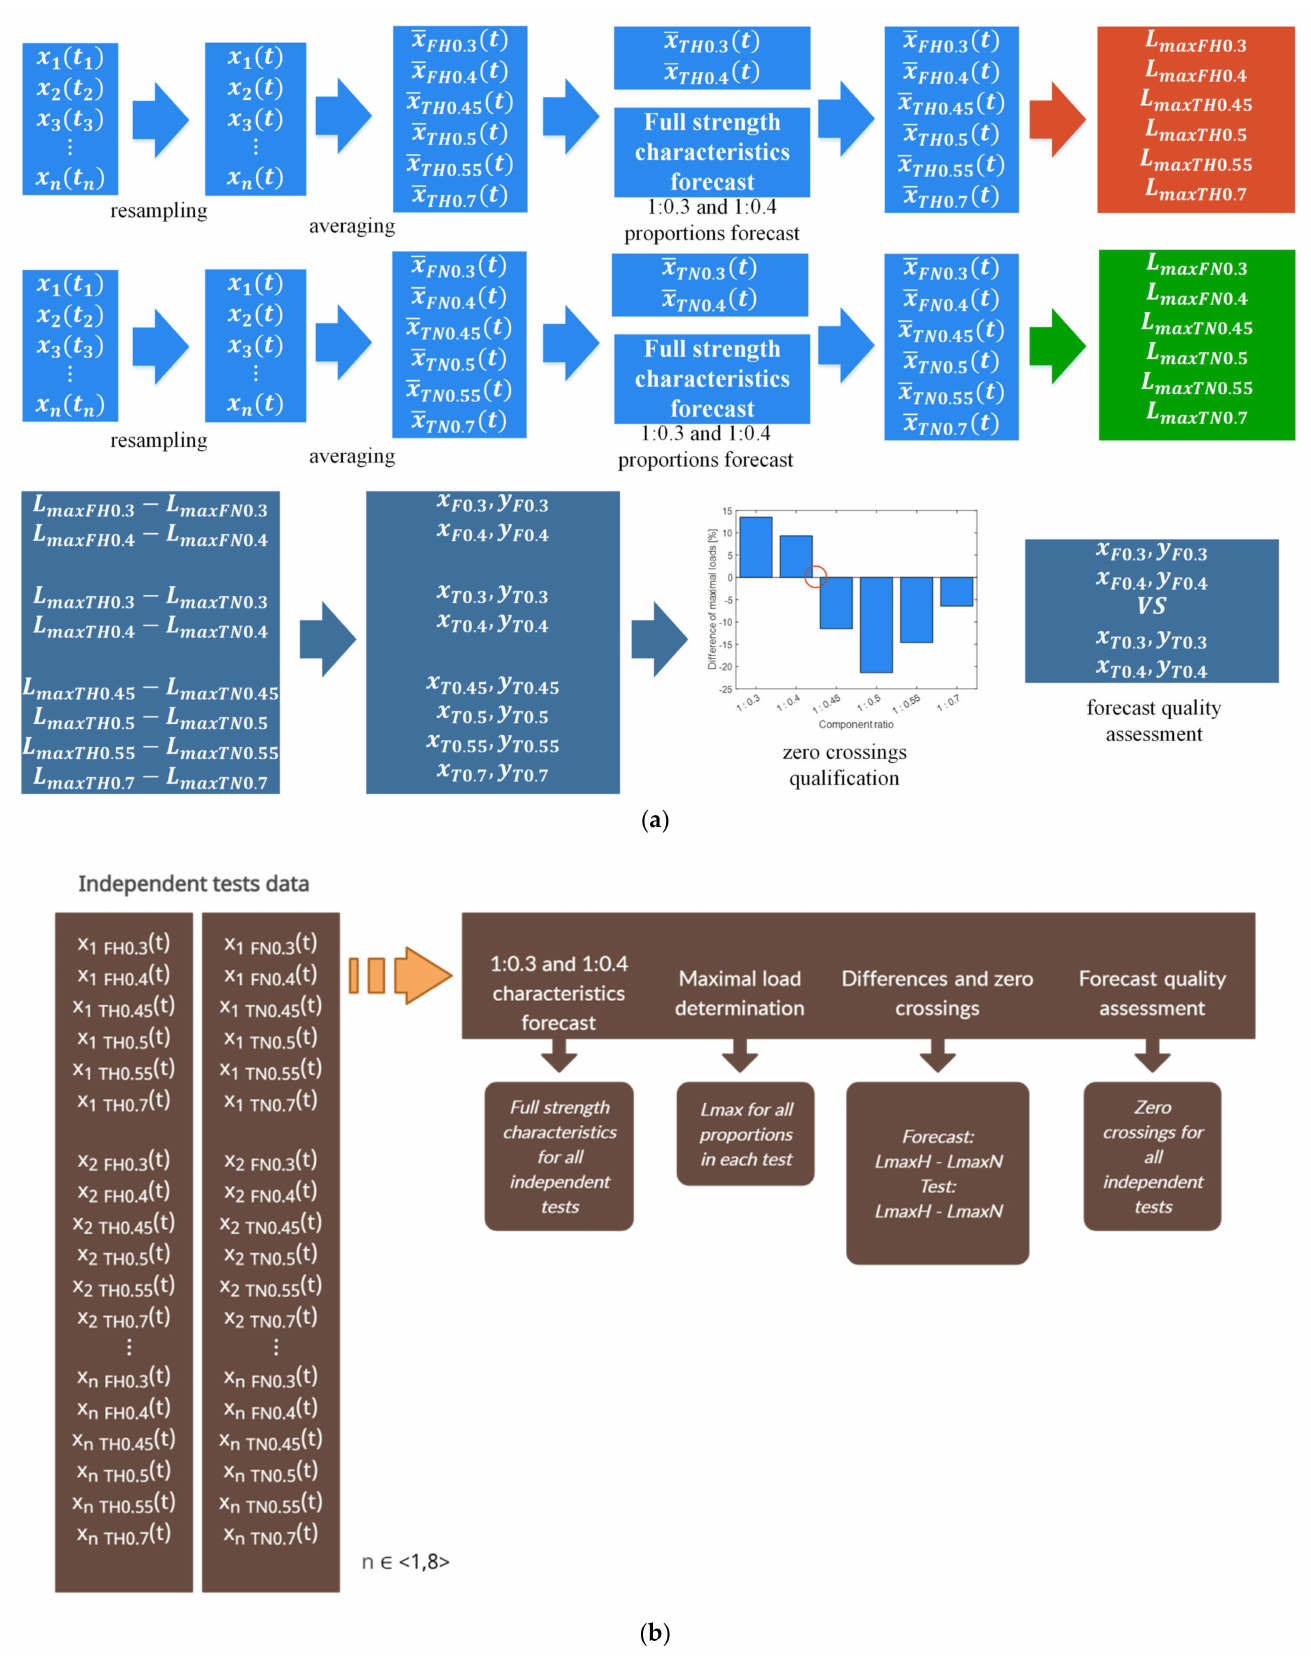
Figure 7. LSTM processing diagram: ( a ) averaged tests and ( b ) independent